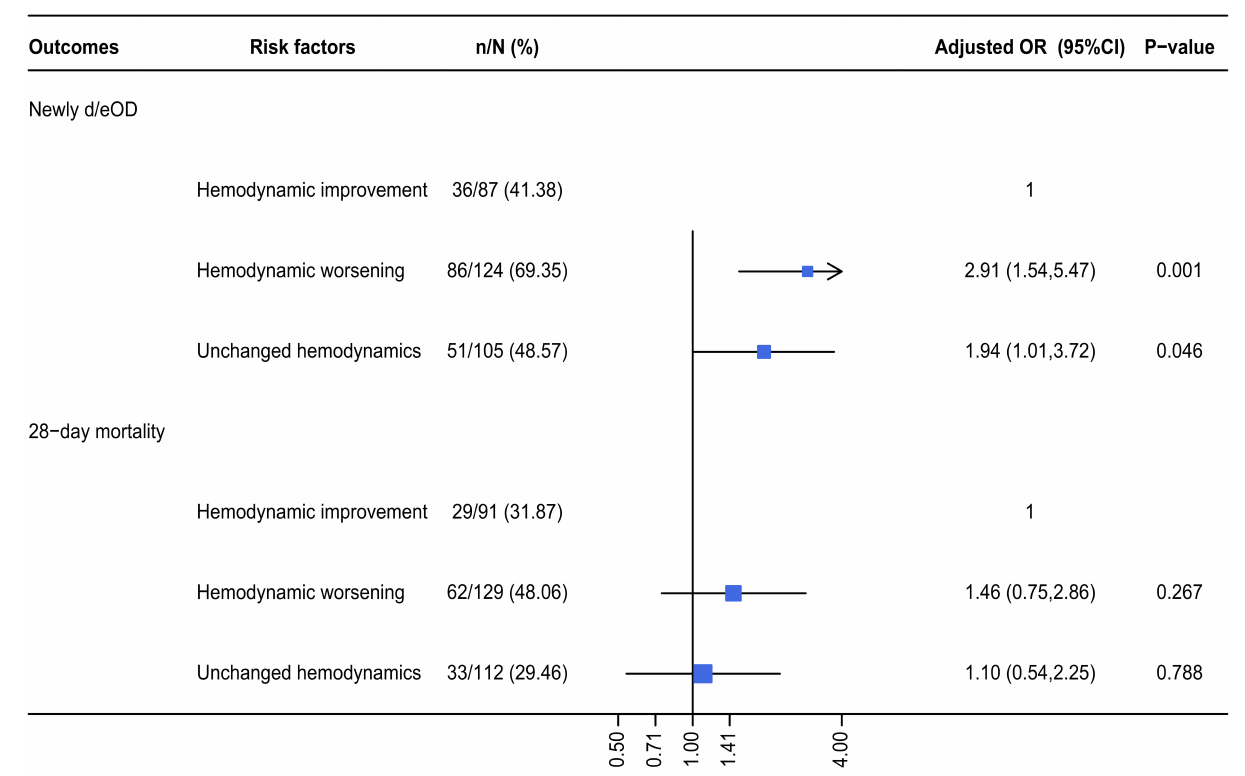
FIGURE 4 | The adjusted OR for a composite of newly d/eOD and 28-day mortality in SB group. Multiple logistic regression was used. For the dependent variable of d/eOD and 28-day death, we adjusted variables including (1) mechanical ventilation within 48h after ICU admission, (2) sepsis diagnosis, (3) ketoacidosis diagnosis, (4) CPR, (5) cumulative fluid balance within 48h after ICU admission, (6) SOFA score during the first 24h after ICU admission, and (7) pH-value. d/eOD, developed or exacerbated organ